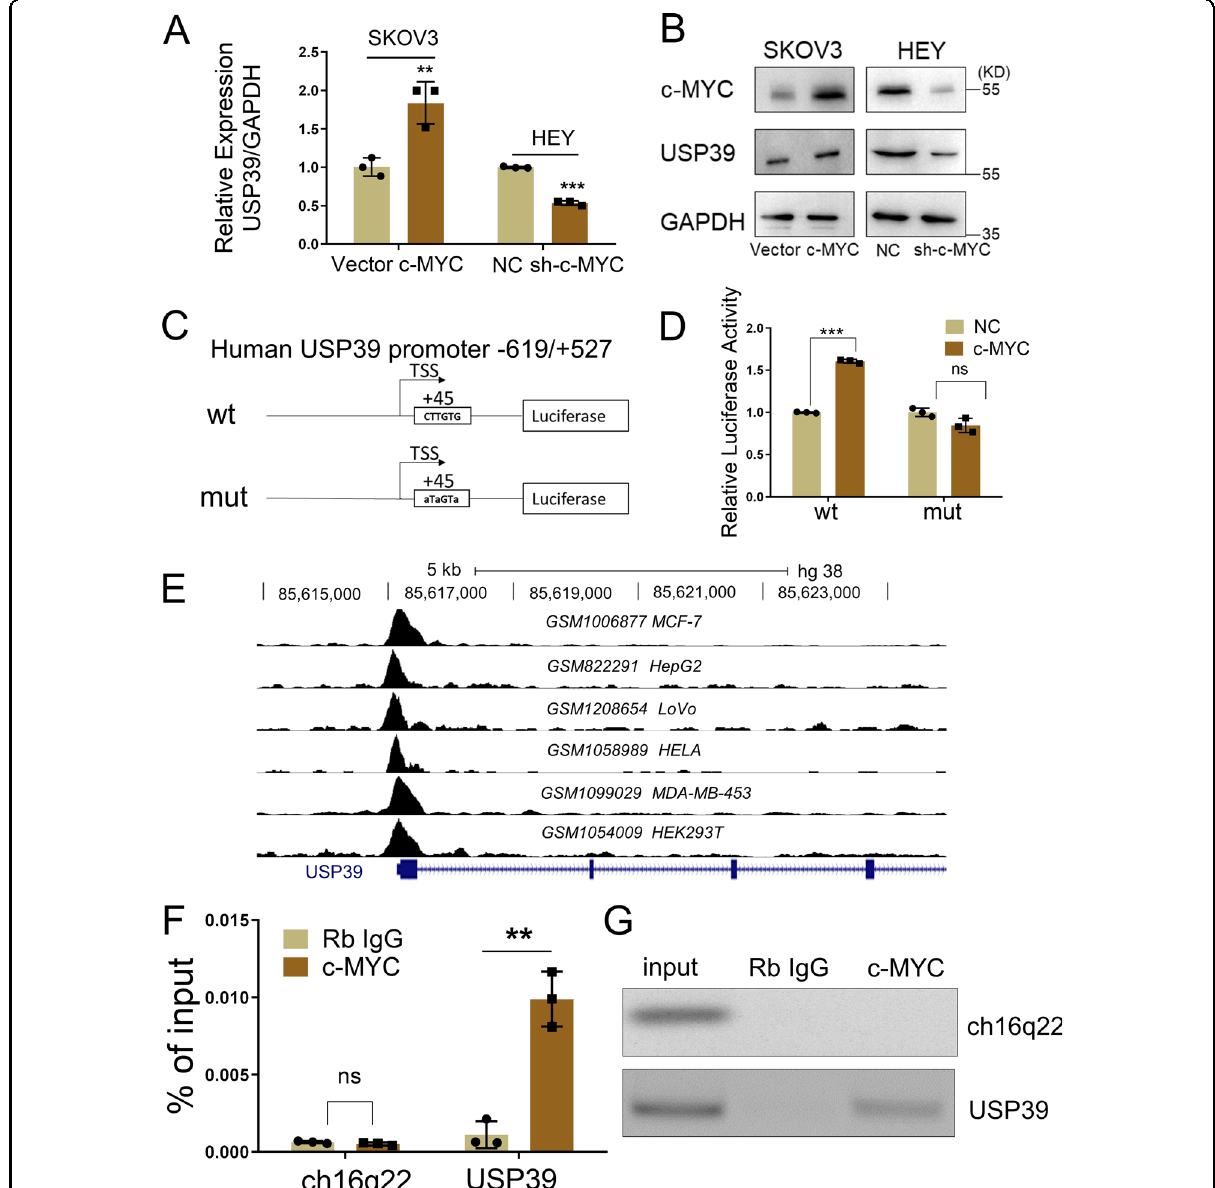
Fig. 4 c-MYC activates the transcription of USP39 in ovarian cancer cells. A Relative expression of USP39 in ovarian cancer cells with c-MYC overexpression (c-MYC) or knock down (sh-c-MYC) compared to corresponding control ( n = 3 biologically independent samples) was measured by qPCR. B Western blot analysis of c-MYC and USP39 protein levels upon c-MYC overexpression or knockdown. C Schematic diagram of the USP39 promoter ( − 619 – + 527) constructs based on the PGL4.26 vector. Wild type (wt) and Mutant (mut) refer to the wild-type and mutant versions of